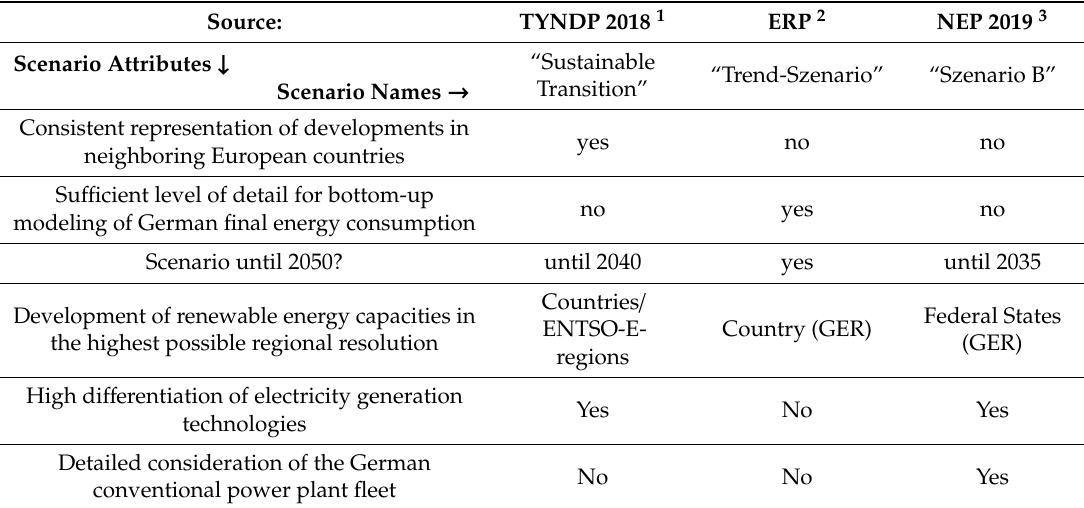
Table 1. Selection and characterization of scenario